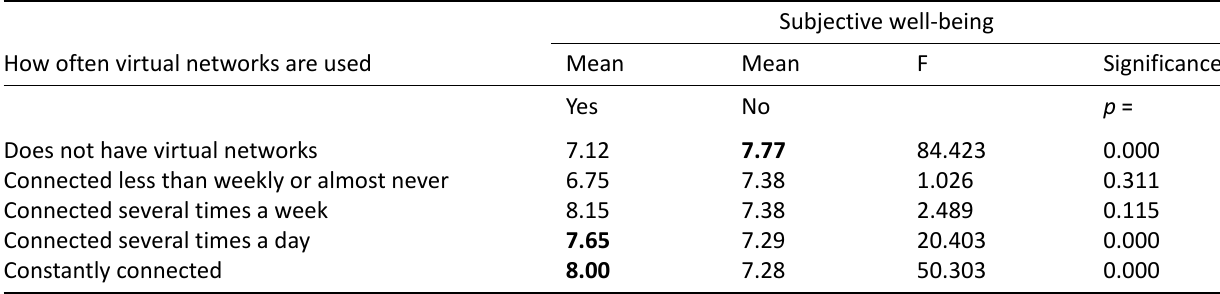
Table 3. ANOVA results for frequency of connection to social media and happiness.